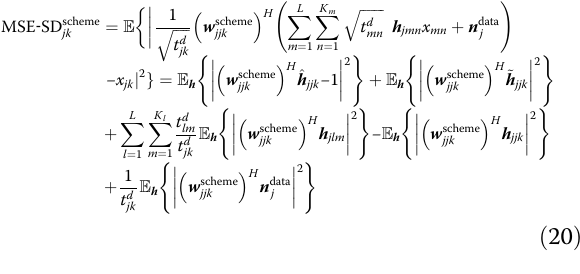
coalition game pilot allocation schemes in Table 3, the condition of the final stability is the no permission of ad- ð j ; k Þ justment S → S Φ .